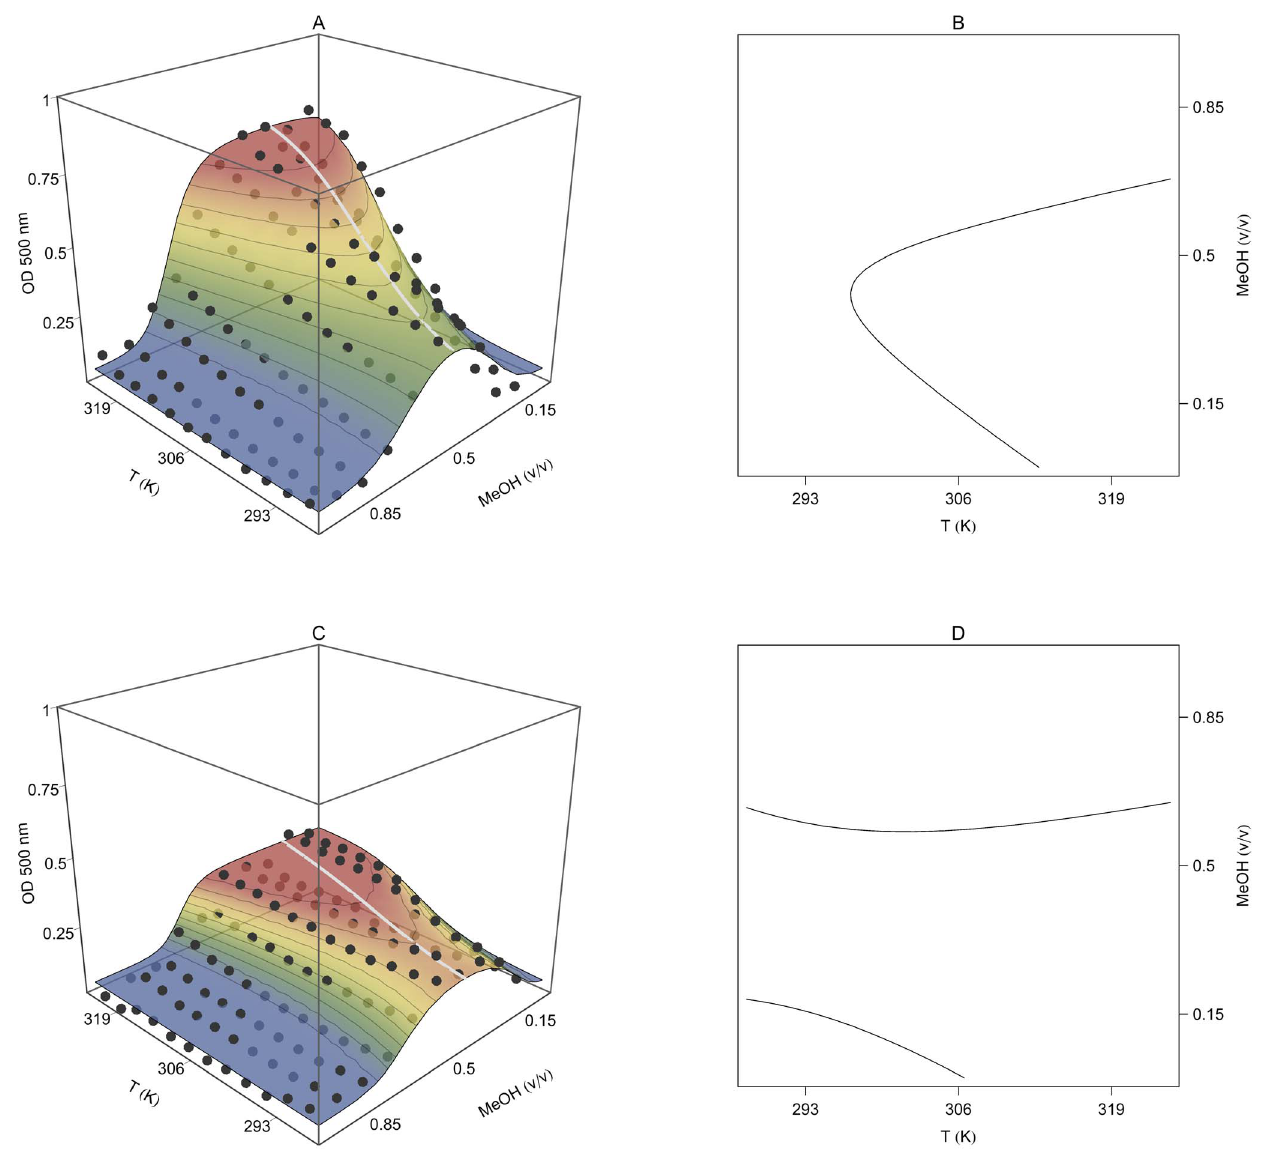
Figure 8. Optical density (OD) variation of PNIPA/AA nanohydrogels as a function of the methanol volume fraction and temperature. PNIPA(5) (A) and PNIPA-20AA(5) (C) nanohydrogels were previously swelled in distilled water (12.5 mg mL 2 1 ) at 25 u C. The surface represents the fitting of the experimental data with the Equation 23. Figures B (PNIPA(5)) and D (PNIPA-20AA(5)) show MeOH-T phase diagrams in which the critical line marks the temperature and MeOH conditions at which the nanohydrogel begins to undergo the volume phase transition. The grey line in Figures A and C, calculated with Equation 27, represents the critical methanol concentration at which the tendency in the nanohydrogel collapse changes.